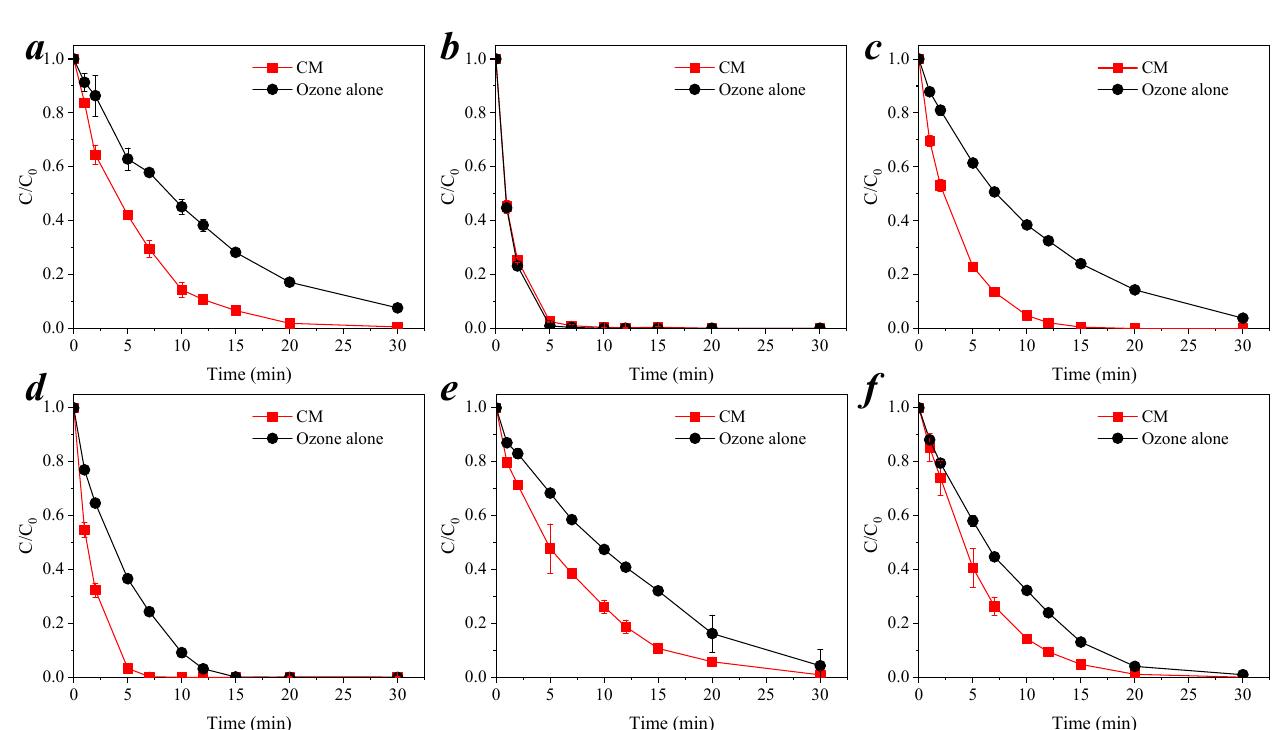
Figure 5. Degradation of organic compounds by CM catalytic ozonation. ( a ) Nitrobenzene; ( b ) p -CA; ( c ) BP-4; ( d ) p -CP; ( e ) p -CNB; ( f ) p -CBA. Conditions: pH = 6.9 ± 0.1, [O 3 ] = 0.5 mg L −1 , [nitrobenzene] 0 = [ p -CA] 0 = [BP-4] 0 = [ p -CP] 0 = [ p -CNB] 0 = [ p -CBA] 0 = 0.064 mM. Table 3. Reaction kinetics of organic pollutant removal by CM catalytic oxidation.